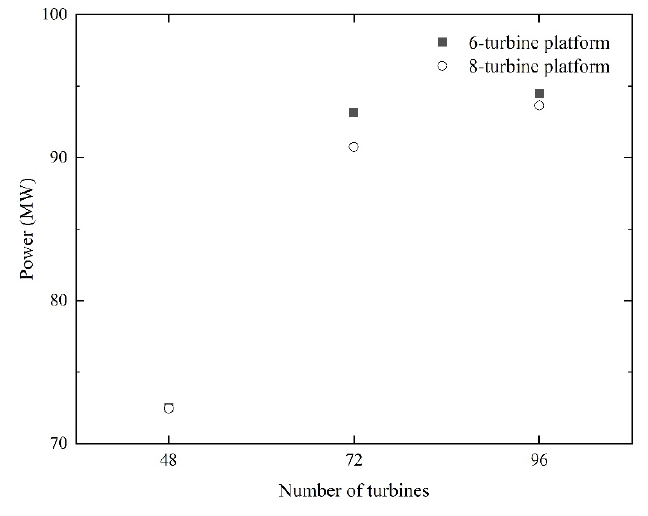
Figure 7. Power production of optimized layouts. Table 4. Optimized power of two kinds of platforms.